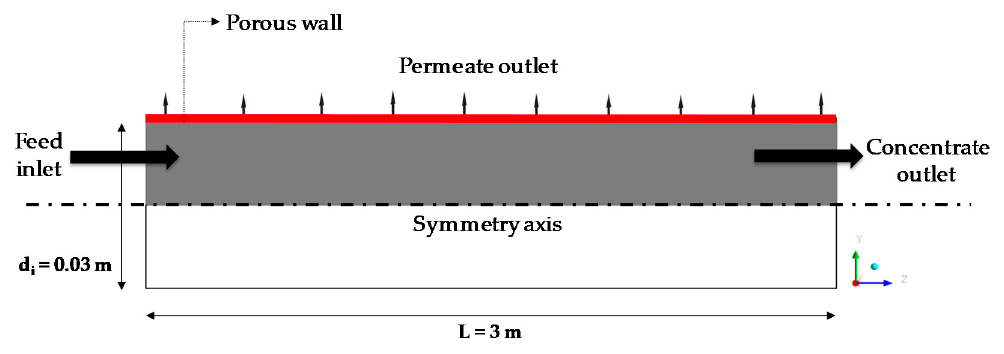
Figure 1. Geometric representation of the tubular membrane and the 2D transverse plane.